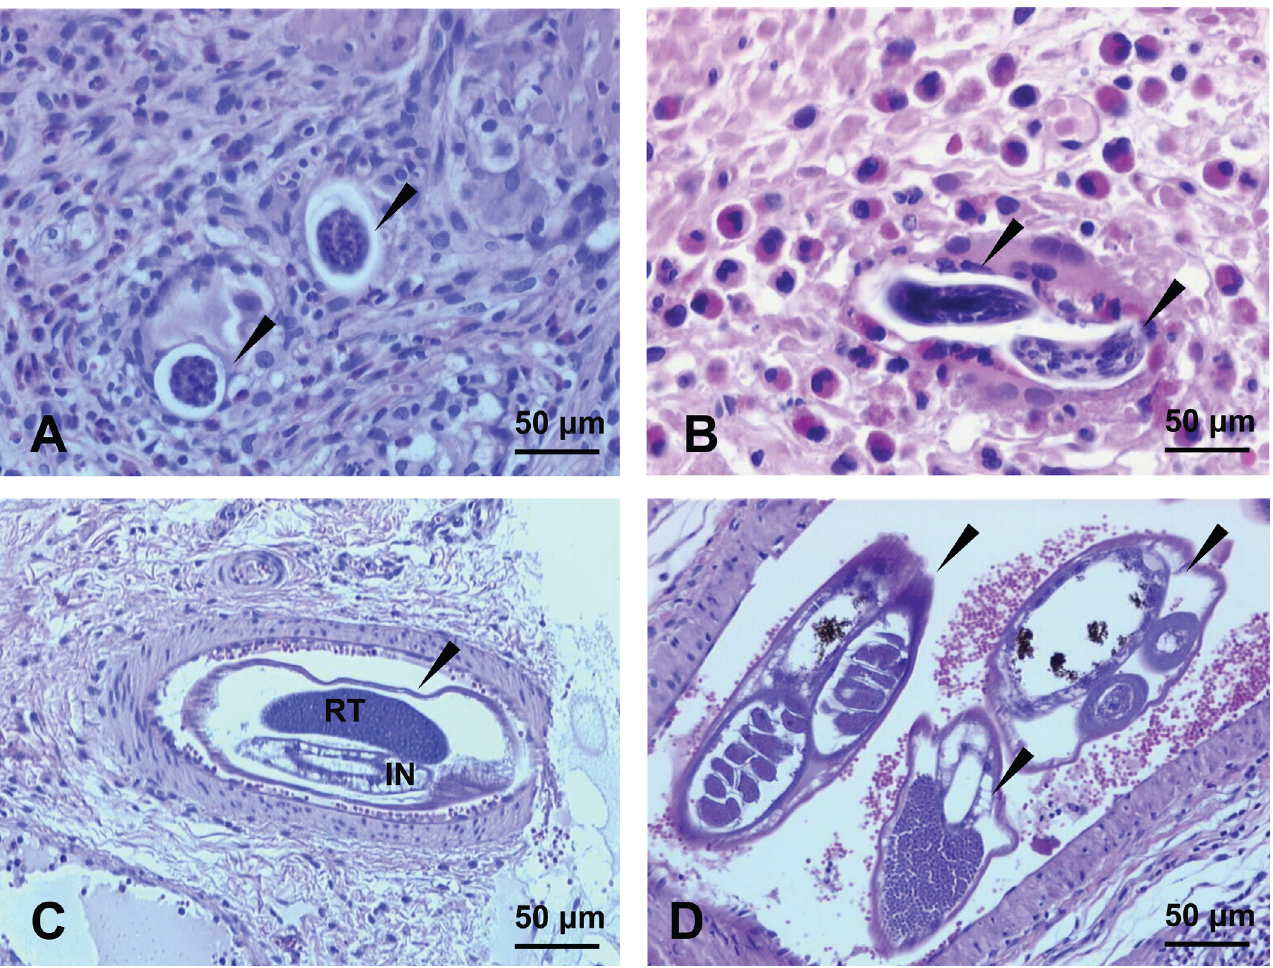
Figure 4. Case No. 2 microscopic aspects of the ileo-colic specimen stained with HES. A. Section of the intestine showing two thin- shelled eggs ( darts ) surrounded by a granulomatous reaction with giant cells (HES, 100x). B. Section of the intestine showing two A. costaricensis larvae( darts )surroundedbyagranulomatousreactionwithgiantcellsandaconsiderablenumberofeosinophilscells(HES, 100x).C.Transversalsectionofa mesentericarteryshowing A.costaricensis adultworm( dart ) with asinglereproductivetube(RT) and intestine(IN)(HES,100x).D.Transversalsectionofamesentericsmallarteryshowingthreesectionsofadultworms( darts